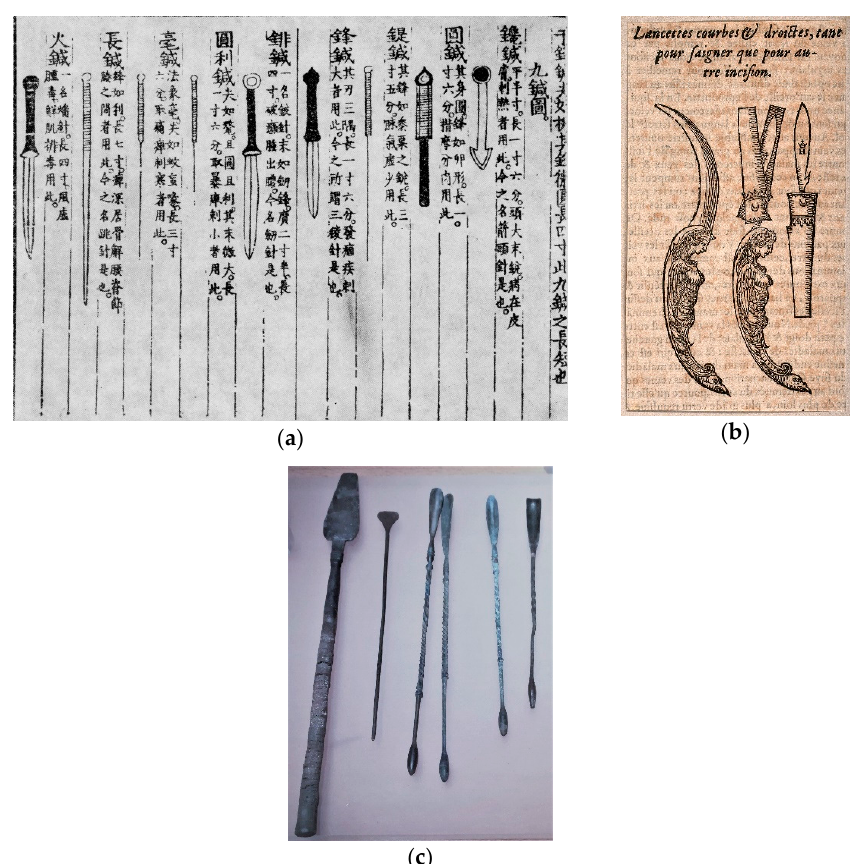
Figure 1. Analogies between ancient Chinese ‘needles’ and European surgical instruments. ( a ) The nine ancient needles of acupuncture and their clinical applications according to Yang Jizhou [ 杨继